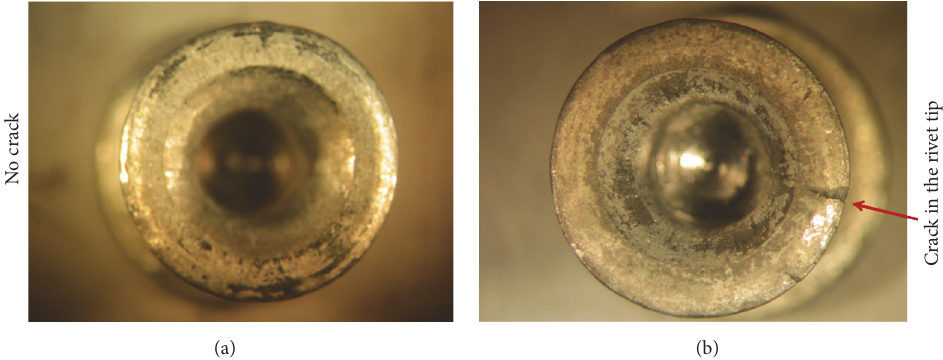
Figure 15: Extracted rivet showing (a) no crack in rivet of joint I (1.5 + 1.5 mm G450) and (b) crack in rivet of joint II (2.5 + 2.5 mm